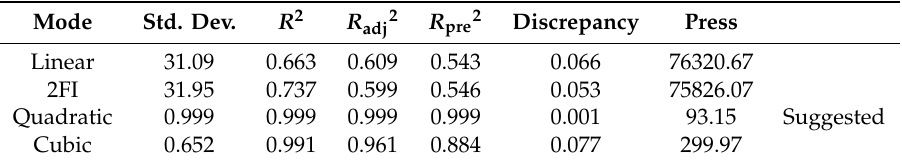
Table 1. Summary statistics of four